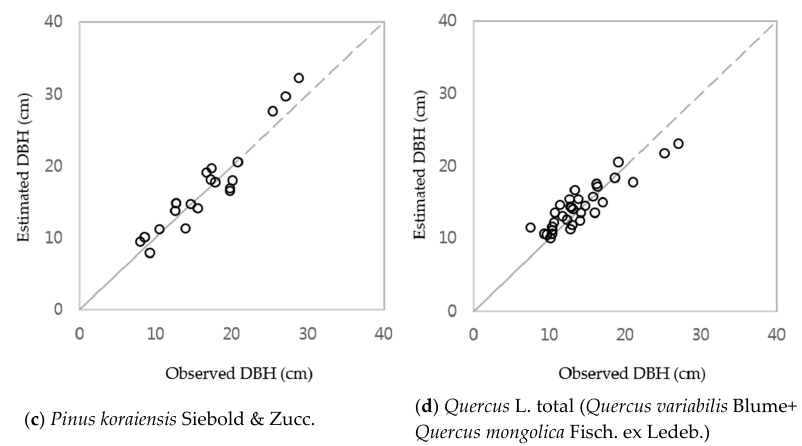
Figure 5. Observed vs. predicted diameter at breast height (DBH) for the major tree species in South Korea.